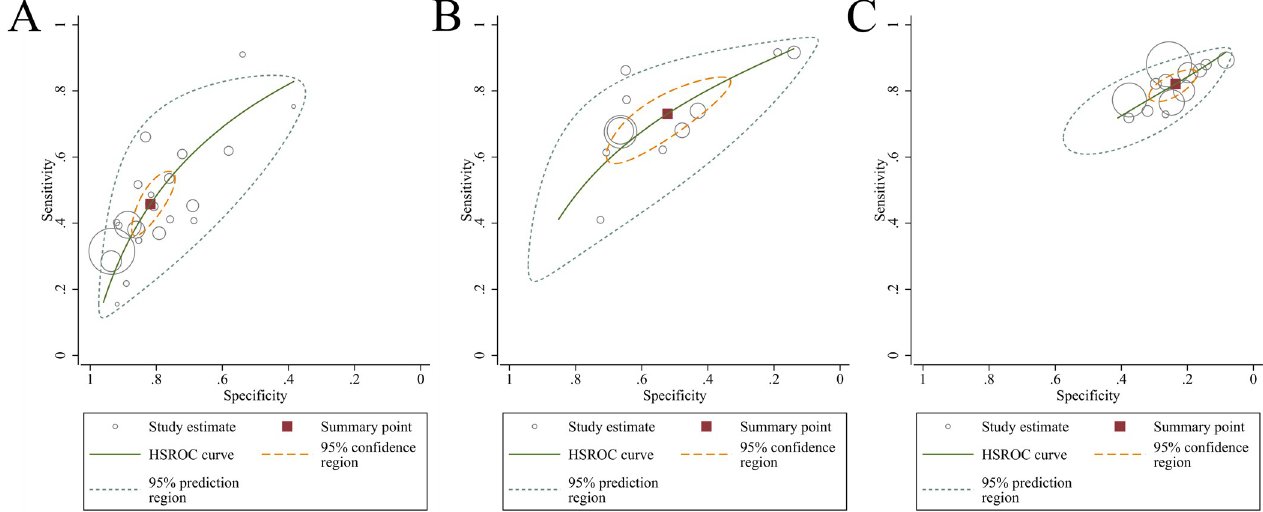
Fig 3. Hierarchical Summary Receiver Operating Characteristic (HSROC) curve for predicting mortality in patients with suspected sepsis. A: qSOFA; B: SIRS; C: NEWS.